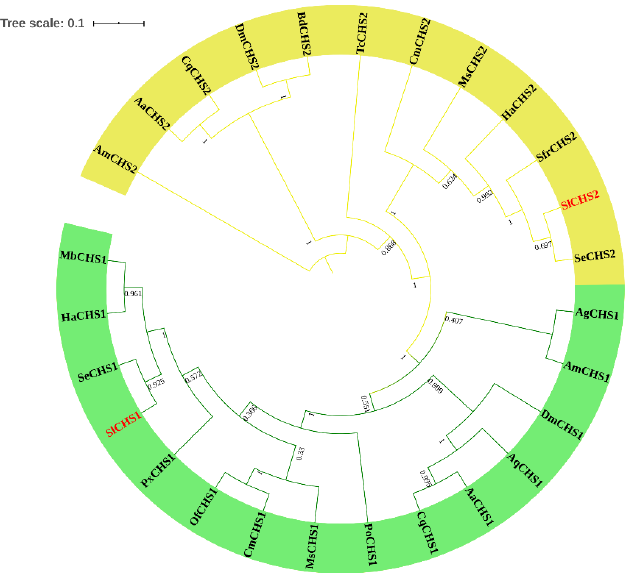
Figure 1. Multiple sequence alignment of the conserved catalytic domain of the chitin synthases (CHSs) from three insect species. CHSs are from Spodoptera litura (Sl), Spodoptera exigua (Se) and Helicoverpa armigera (Ha). Seven characteristic motifs (M 1-7) for insect chitin synthases are indicated with red boxes.